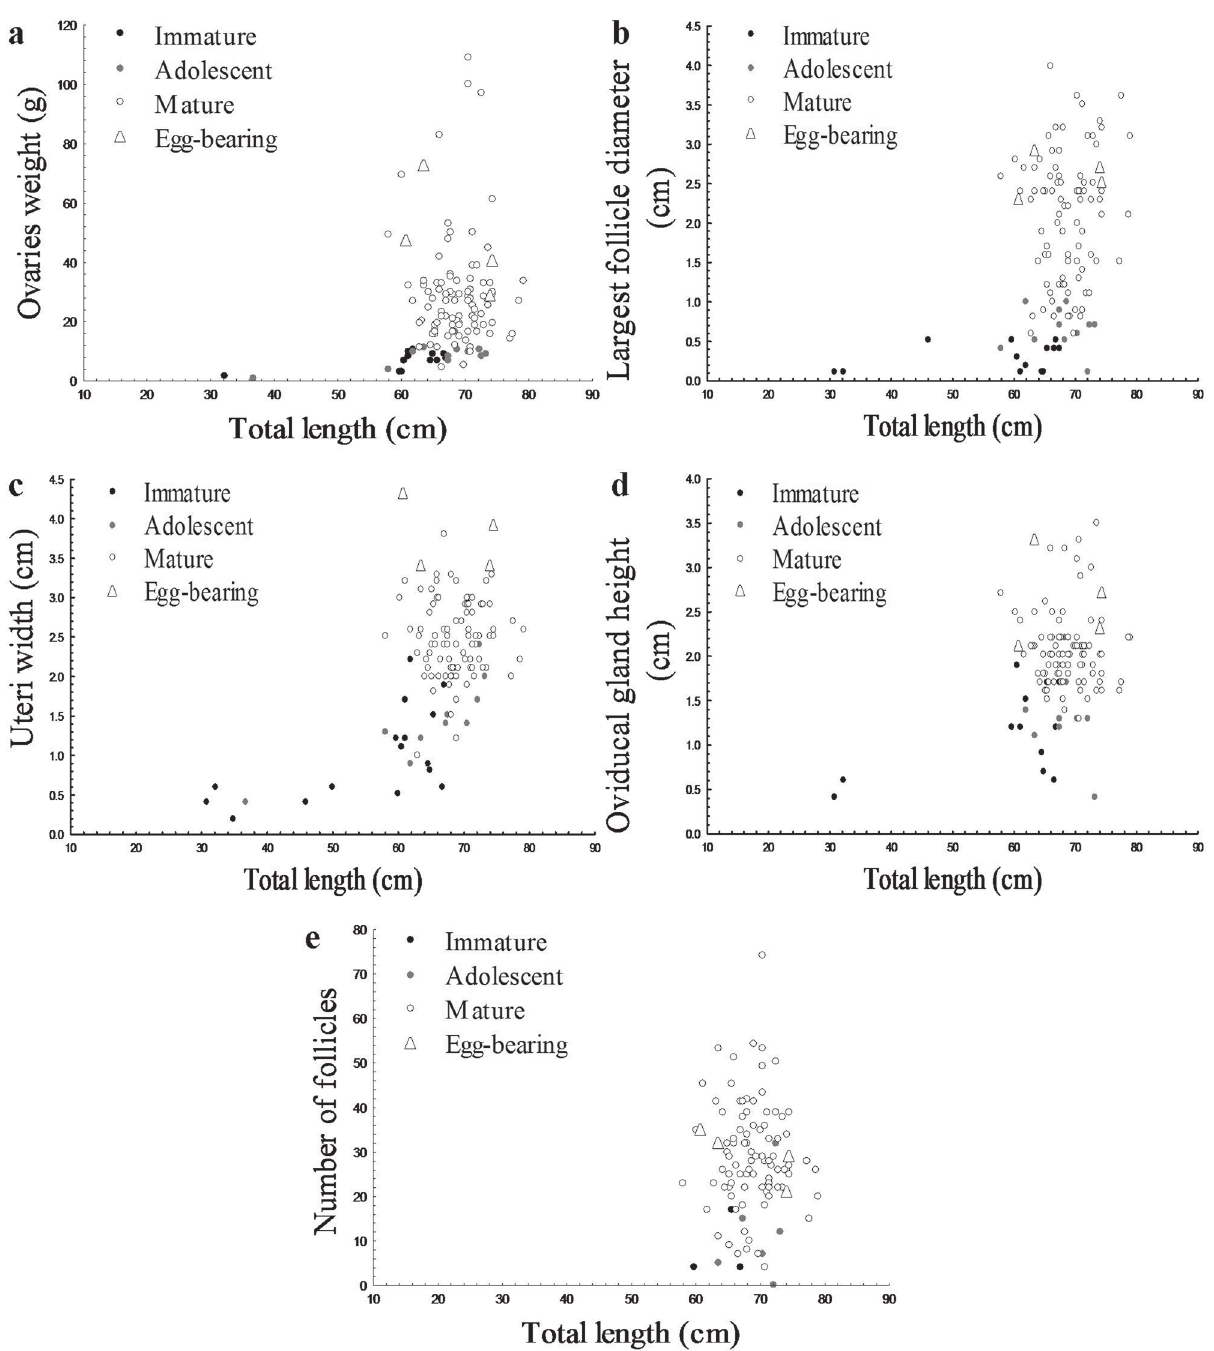
Fig. 6. Sexual development for females of Sympterygia bonapartii . Relationship between total length (cm) and (a) ovaries weight (g), (b) diameter of the largest follicle (cm), (c) uteri width (cm), (d) oviducal gland height (cm) and (e) number of